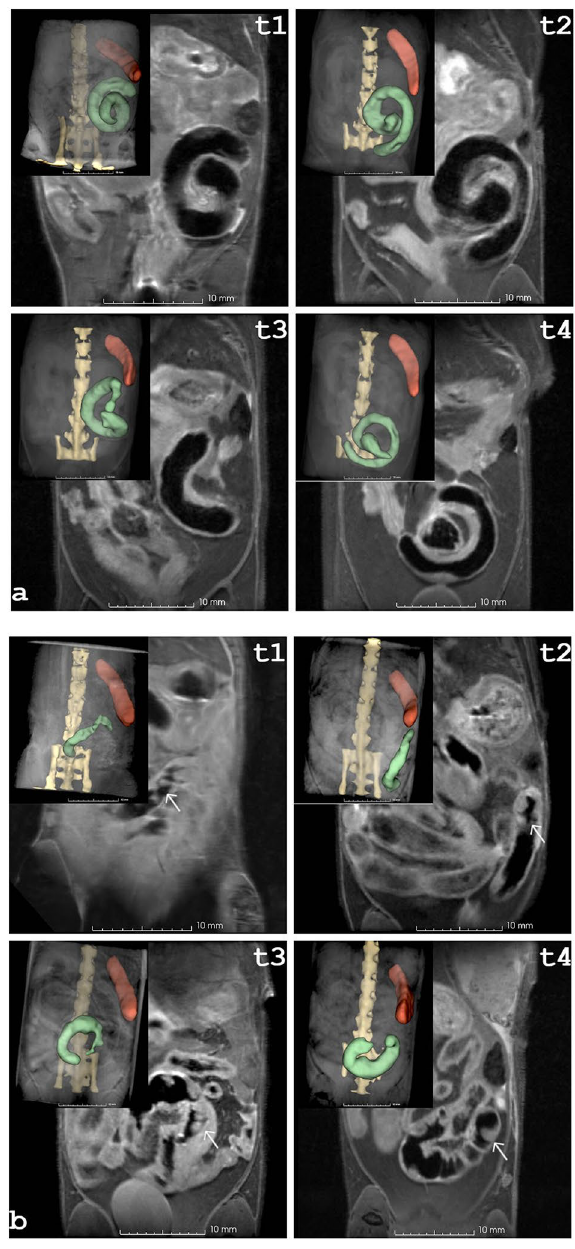
Figure 2. Comparison of cecal development in a female control mouse ( a ) and a female mutant mouse ( b ) along the first four time points (t1–t4). The spine is colored yellow, the spleen is shown in red and the cecum is colored green. At two (t1) and four (t2) months of age, the cecum of the mutant had an elongated shape, whereas the cecum in the control group was arranged in a coiled shape. At later time points, the shape of the mutant cecum resembled the anatomy of the control. Peyer´s patches were clearly visible in the inner wall of the mutant cecum (marked by white arrow in b